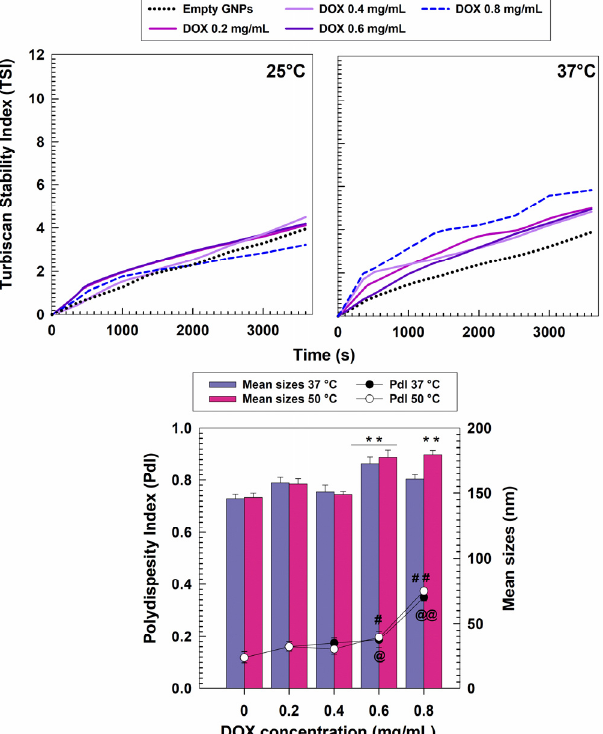
Figure 2. TSI profiles of gliadin nanoparticles (1 mg/mL of protein and 0.1% w/v of polyoxyethylene (2) oleyl ether) containing various amounts of DOX (0.2 − 0.8 mg/mL). The analyses were performed at room and body temperature for 1 h. Evaluation of the mean diameter and size distribution of gliadin nanoparticles as a function of the drug concentration and incubation temperature. Error bars if not shown are within symbols. Values are the result of three experiments ± standard deviation. ** p < 0.001 with respect to the mean sizes of the empty formulation analyzed at 37 °C and 50 °C, respectively. @ and # p < 0.05 with respect to the PdI of the empty formulation analyzed at 37 °C and 50 °C, respectively; @@ and ## p < 0.001 with respect to the PdI of the empty formulation analyzed at 37 °C and 50 °C, respectively. Table 1. Physico-chemical features of GNPs (1 mg/mL of polymer, 0.1% w/v of polyoxyethylene (2) oleyl ether) prepared with various amounts of DOX as a function of the incubation